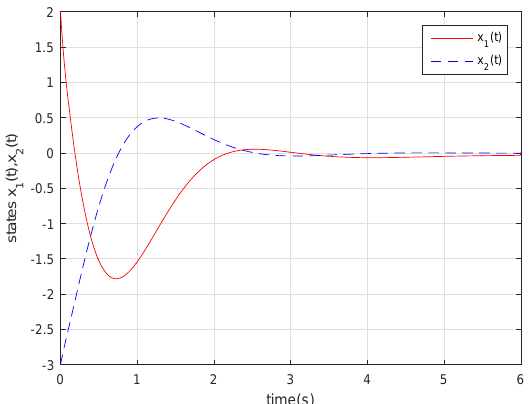
Figure 2. Time response of the selected systems with control input in the Example